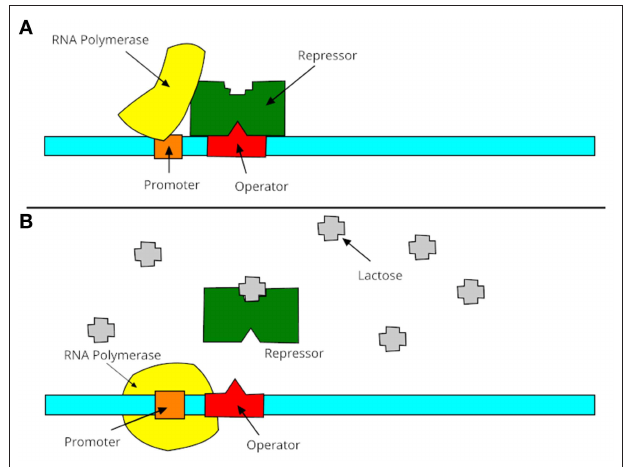
FIGURE 1 | Process of promoters in transcription. (A) The gene is essentially turned off. The repressor is not inhibited by lactose and binds to operator, then promoter is bound to make lactase; (B) the gene is turned on. The repressor is inhibited by lactose, then the promoter is bound by the RNA polymerase and express the genes to synthesize lactase. Finally, the lactase will digest all of the lactose, until nothing binds to the repressor. The repressor will then bind to the operator, stopping the manufacture of